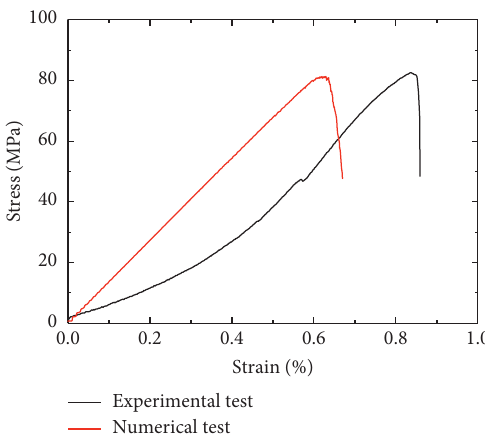
Figure 2: Stress-strain curves of sandstone based on experimental and numerical